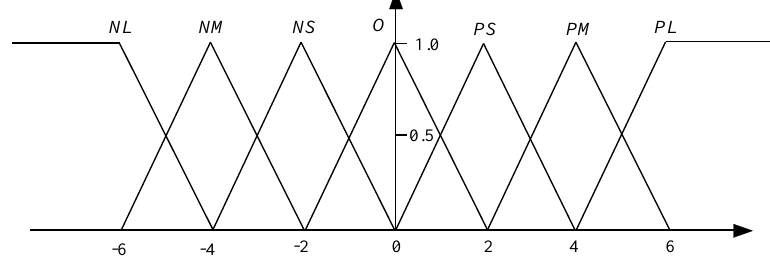
Figure 9. Membership functions of the linguistic variables.